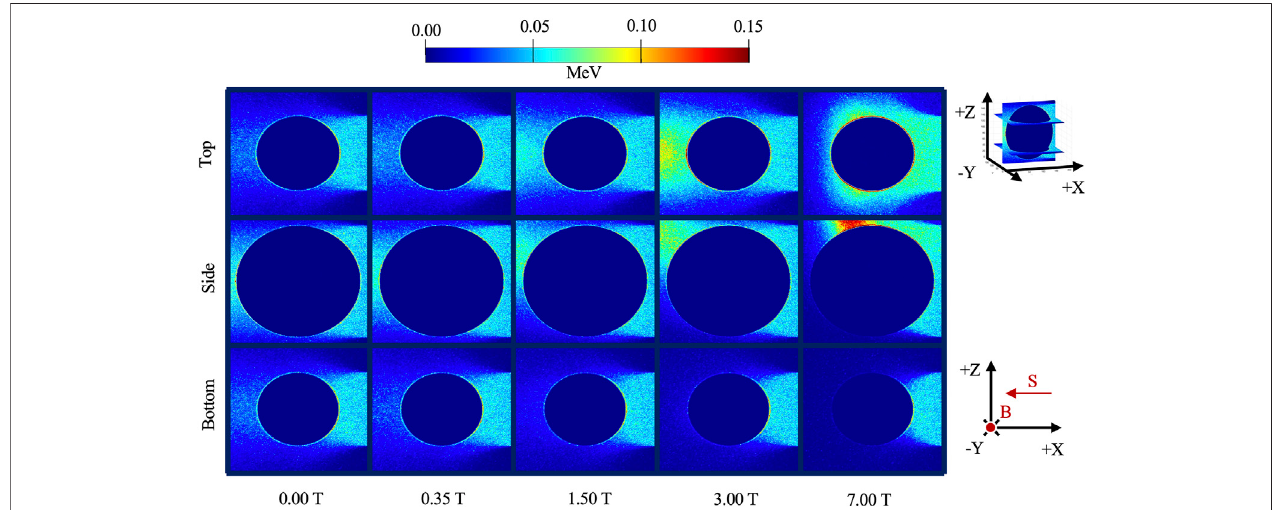
FIGURE 3 | Energy deposition in the alveolus model irradiated with 100 keV electrons in the presence of varying magnetic fi eld strength. The side view was acquiredinthe100thslicealongthe y -axiswhilethetopandbottomviewswereacquiredatthe30thand170thslicealongthe z -axis,respectively(shownbytheinsert).B designates the direction of the magnetic fi eld and S is the direction of the electron beam source.